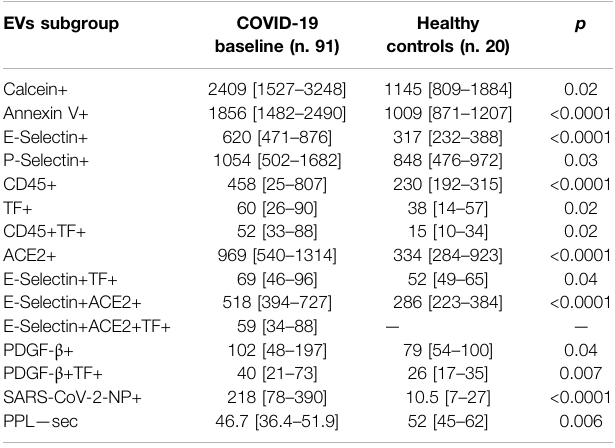
TABLE 1 | Baseline characteristics and COVID-19 therapeutic protocols of the study population. COVID-19 patients n. 91